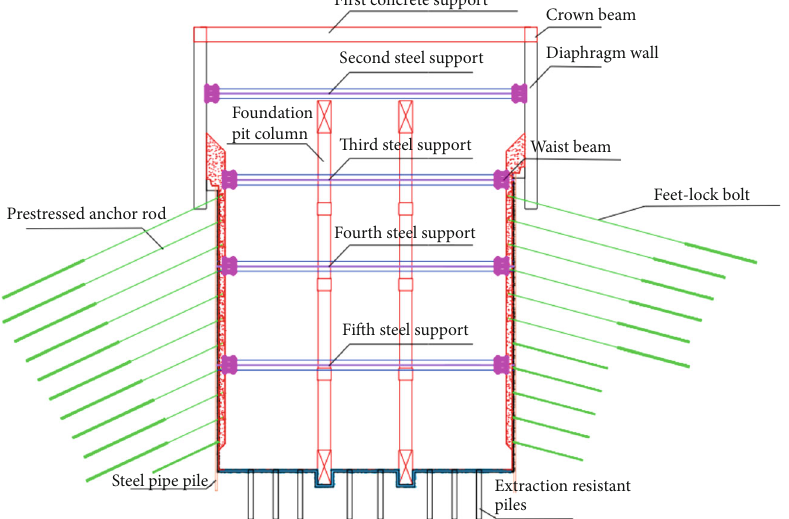
Figure 3: Enclosure system of the deep foundation